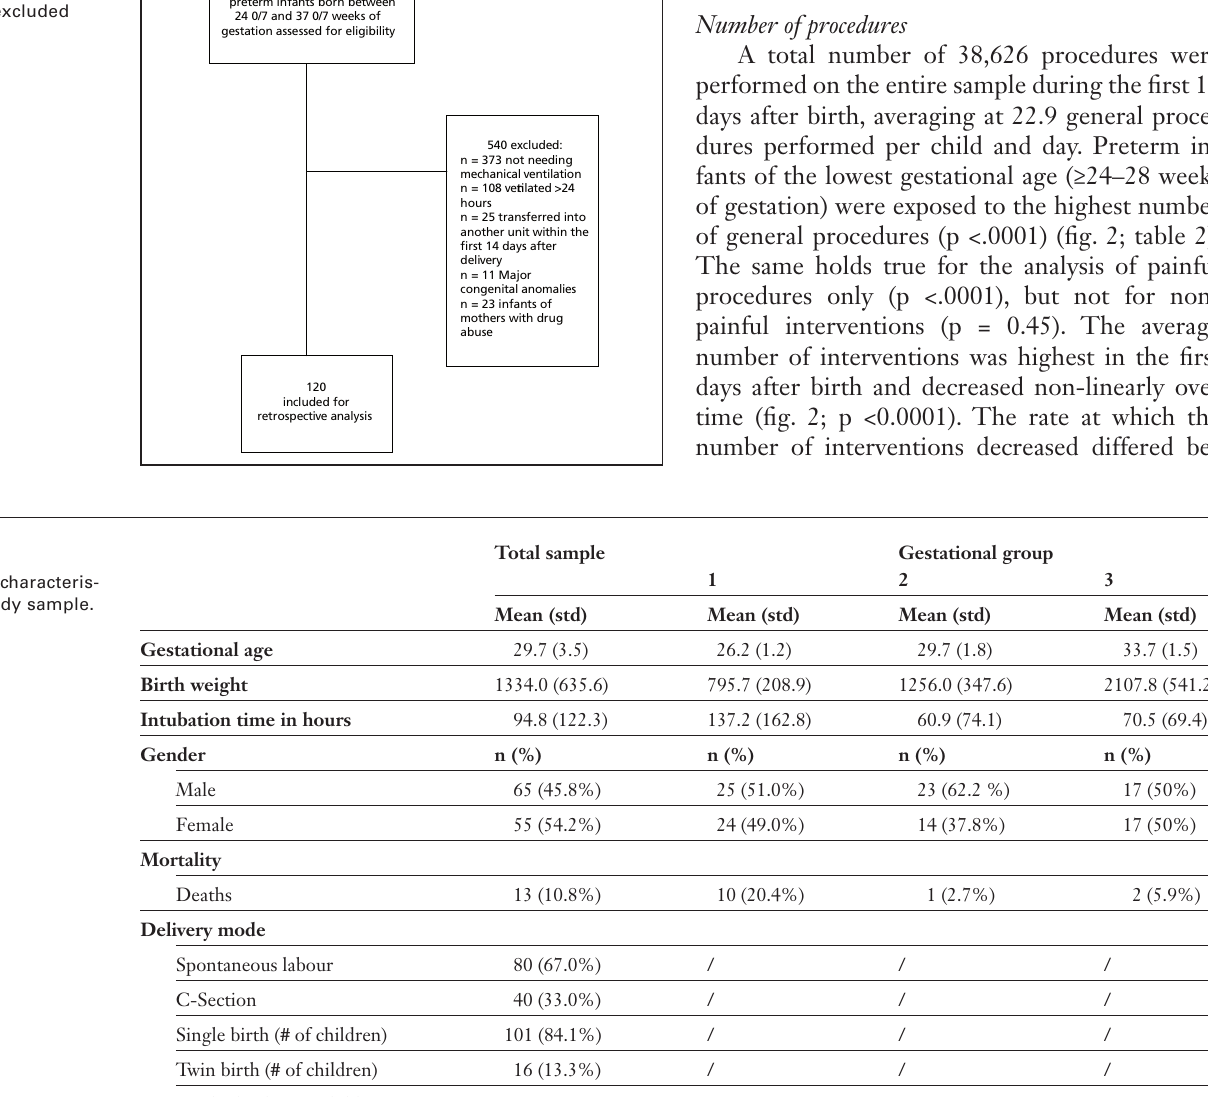
Flow chart of inclu- ded and excluded infants.